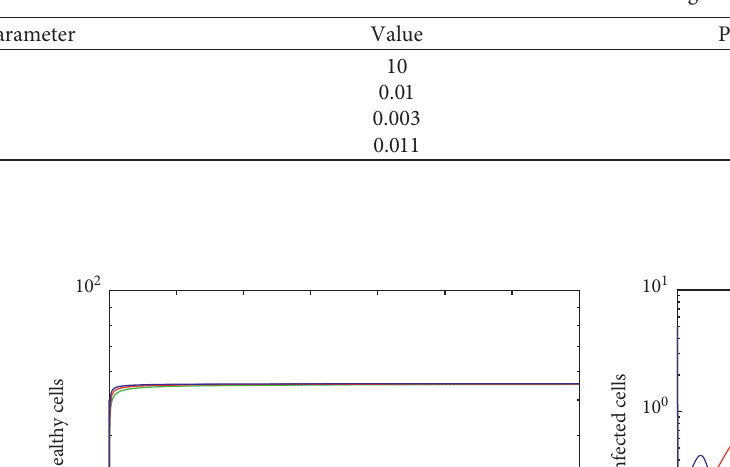
Table 1: Parameters in Figure 1.